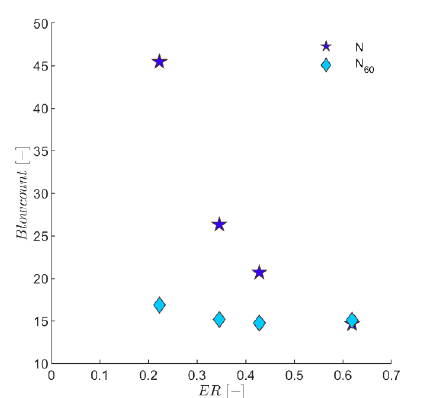
Fig. 3. Raw and normalized blowcounts versus energy ratio for various dynamic